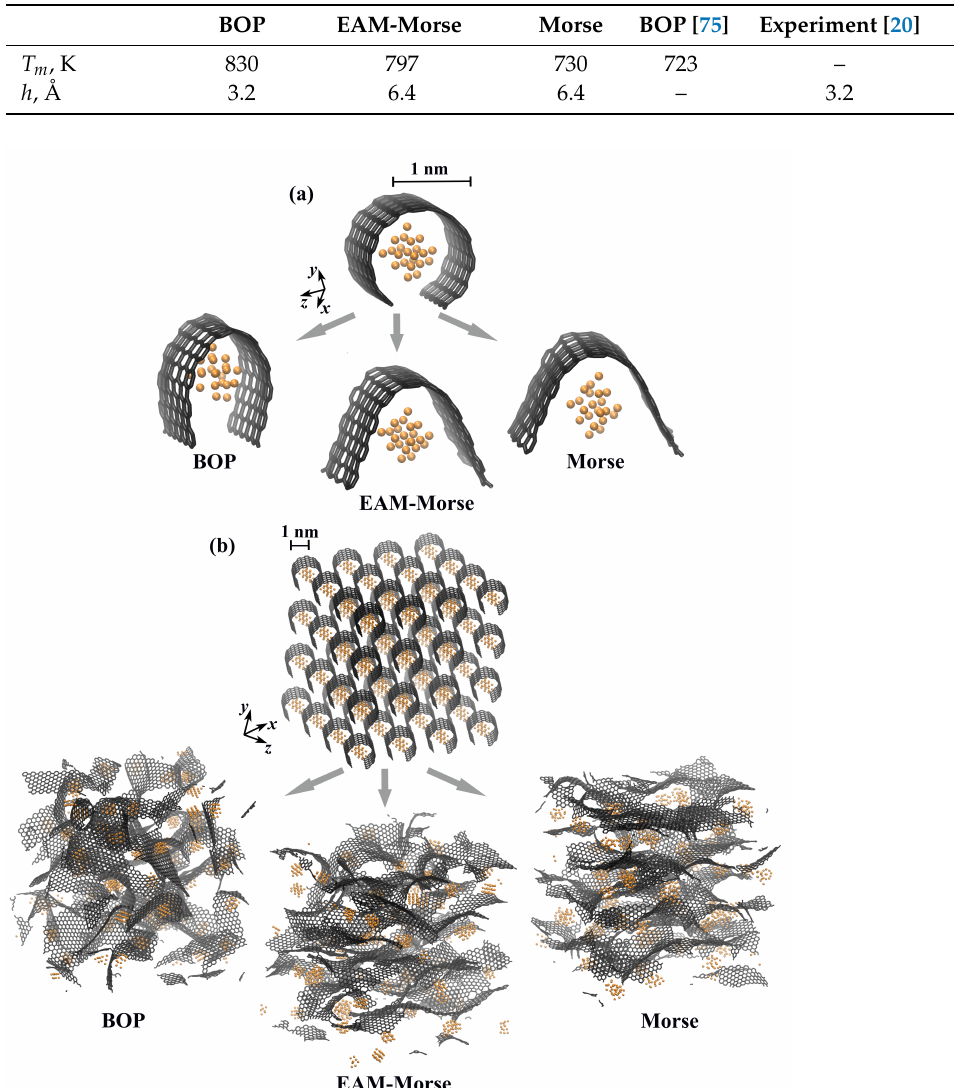
Table 1. Melting temperature of Cu nanoparticle T m and equilibrium distance between Cu atom and graphene layer h obtained with different methods.